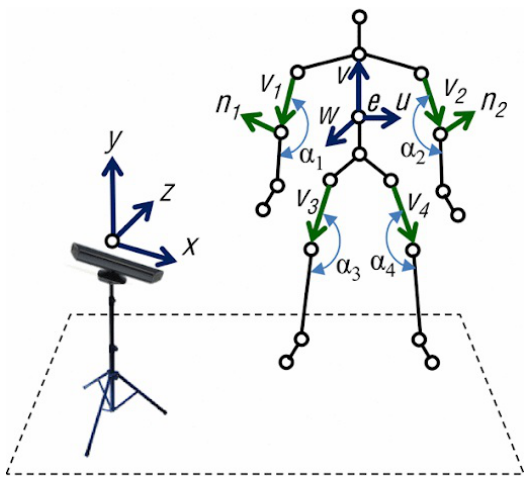
Fig. 10 Plan view of human bone features.